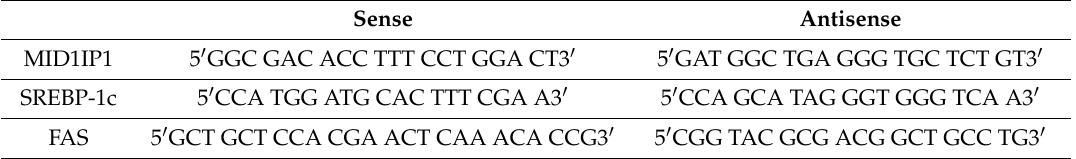
Table 1. Primers used for quantitative real-time PCR (qPCR) in this study.